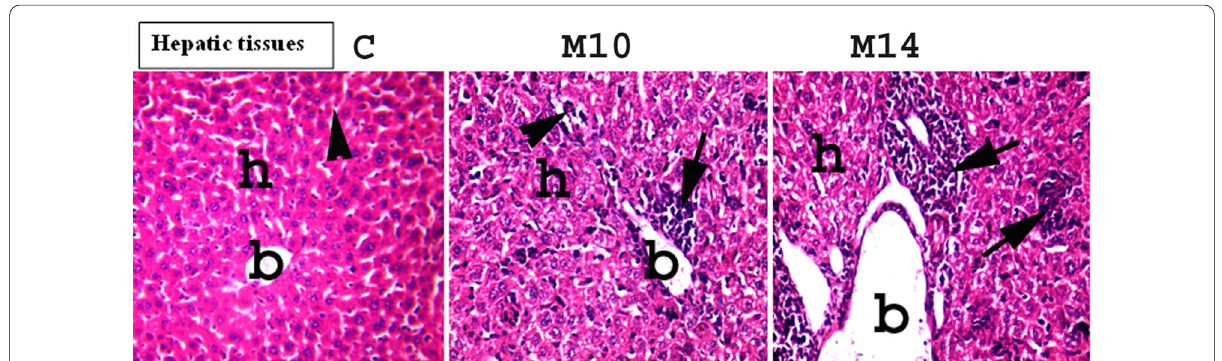
Fig. 3 A photomicrograph of hepatic section. (C) Control group; (M10) monosodium glutamate treated mice for 10 days and (M14) monosodium glutamate treated mice for 14 days. Hepatocyte (h); blood vessels (b); aggregation inflammatory cells (arrow); sinusoids (arrow head). H